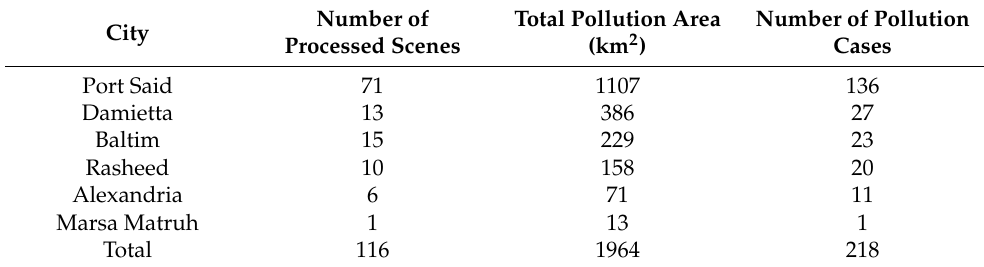
Table 2. Number of oil spill accidents for Egypt’s main coastal cities.